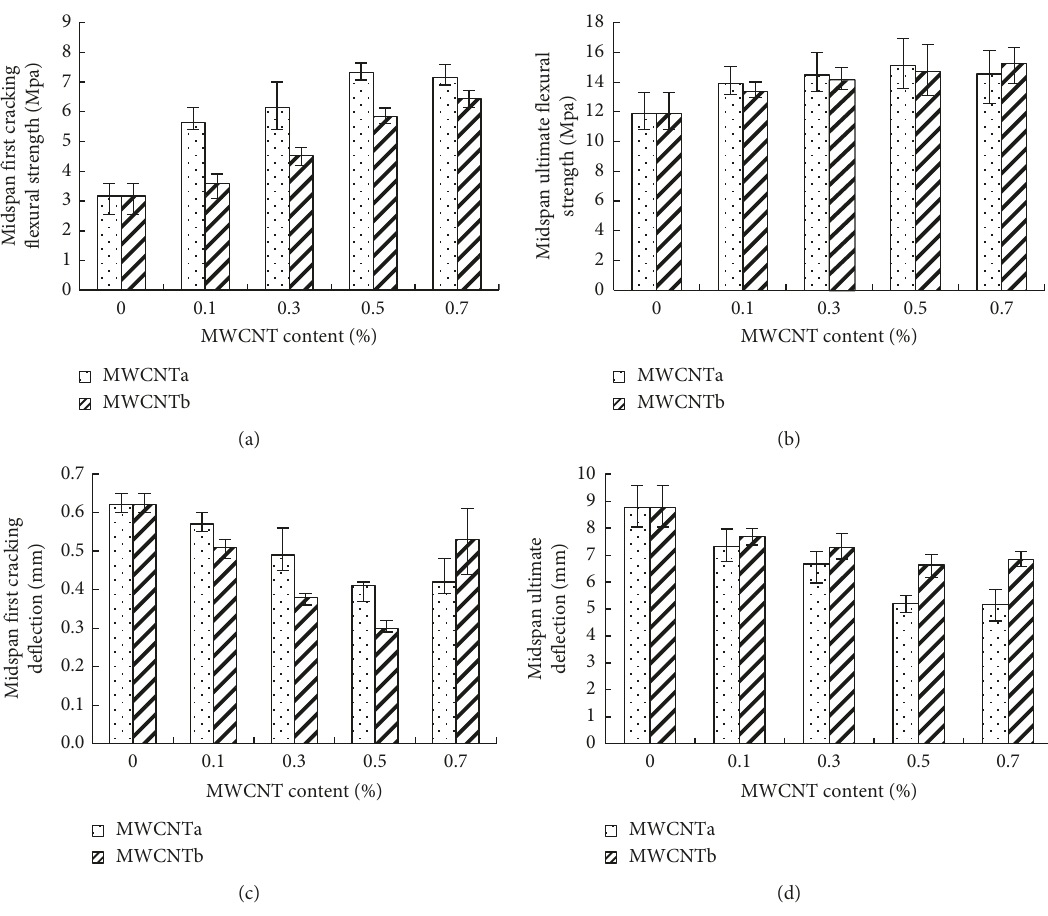
Figure 6: Stress-deflection curves of the flexural test for ECCs containing different MWCNTs. (a) First cracking flexural strength of MWCNT-ECCs. (b) Ultimate flexural strength of MWCNT-ECCs. (c) Midspan first cracking deflection of MWCNT-ECCs. (d) Midspan ultimate deflection of MWCNT-ECCs.